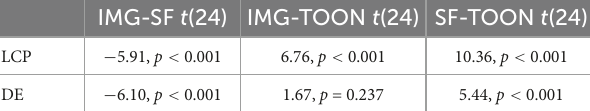
TABLE 2 Post-hoc results for variables LCP and